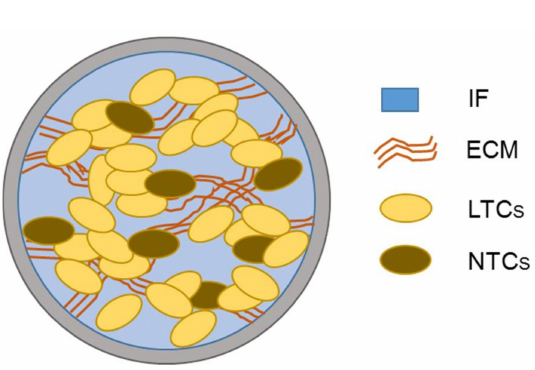
Figure 1. The TCs are divided in living tumor cells, LTCs, and necrotic tumor cells, NTCs. In the IF phase, transported species (nutrients) are considered. The volume fraction of the solid phase ECM is ε s = 1 − ε . The other phases, tumor cells ( ε t ) and interstitial fluid ( ε l ), occupy the rest of the volume so that the volume fractions for all phases add up to unity.